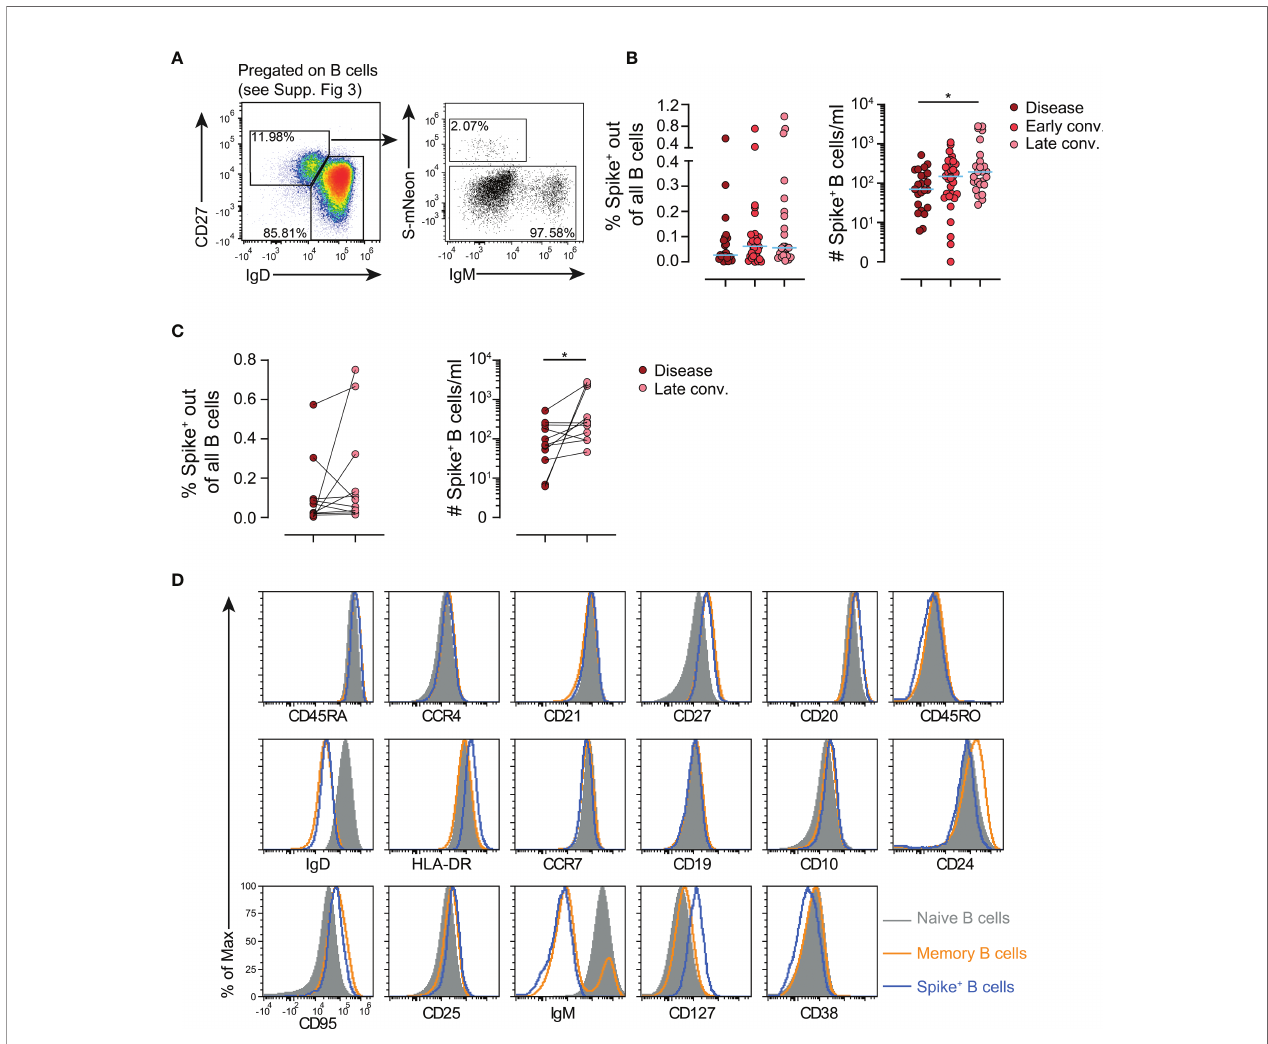
FIGURE 2 | Deep pro fi ling of circulating Spike- speci fi c B cells by fl ow cytometry in patients. (A) Gating strategy for identi fi cation of Spike- speci fi c B cells. Spike + B cell gate was set based on the background level binding of CD3 + T cells. (B) Frequencies (left) and absolute numbers (right) of Spike- speci fi c B cells in patients with disease or in early and late convalescence. Each dot represents one biologically individual sample taken from one patient. n (disease)=24; n (Early conv.)=32; n (Late conv.)=25. (C) Longitudinal analysis of frequencies (left) and absolute numbers (right) of Spike- speci fi c B cells in patients 3-7 months after the disease. Each connected dot represent one individual patient ( n =11). (D) Phenotype comparison of endogenous naïve and memory B cells and Spike- speci fi c B cells. Shown is one representative sample from a patient in late convalescence. Statistics: Kruskal-Wallis multiple comparison test with Dunn ’ s post hoc correction.